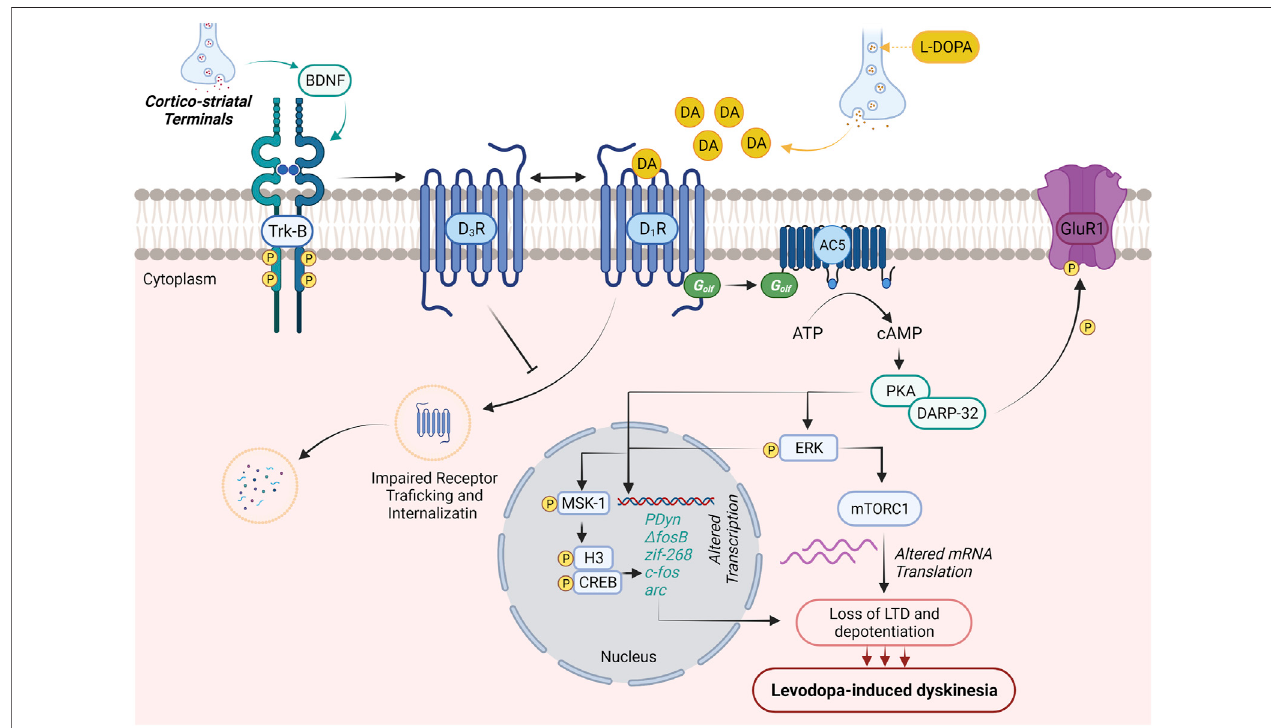
FIGURE 1 | Molecular neurobiology of levodopa-induced dyskinesia. DA production generally regulates voluntary movements. In PD patients, initial dopaminergic neurodegeneration in substantia nigra pars compacta is asymptomatic. Loss of striatal – nigral neuronal sensitizes the D1 receptor on the medium spiny neurons of the direct pathway. This results in initial motor symptoms of PD (dyskinesia). The treatment with L-DOPA improves the initial motor symptoms and promotes BDNF release from corticostriatal neurons. The expressed BDNF potentiates the expression of D3Rs through the activation of Tr κ -B receptors in nigrostriatal medium spiny neurons. Enhanced expression of D3Rs suppresses internalization and abnormal traf fi cking of membrane-bound D1Rs, thus intensifying D1R sensitization and associated dyskinesia. Activation of D1R by DA (released through L-DOPA) results in the activation of D1R/G α olf/adenylyl cyclase 5 (AC5) machinery in nigrostriatal medium spiny neurons and causes cAMP-mediated hyperexpression of protein kinase A (PKA) and DARPP-32. The abnormal PKA/DARPP-32 expression results in hyper-phosphorylation of GluR1 and promotes the excitability of medium spiny neurons contributing to the loss of long-term depression and depotentiation and developmentofLID.Ontheotherhand,activationofD1RresultsintheRas/Raf/MEK/ERKsignalingpathway,whichfurtherpotentiatesRas/Rafmachineryandregulates various transcription and translation processes regulating LID. PKA/DARPP-32 and/or ERK/Elk/MSK1 signaling migrates to the nucleus, leads to phosphorylation of CREB/histone H3, and augments the expression of immediate early genes (prodynorphin and Δ FosB), which are reported to contribute to the development of LID. Activated ERK further elevates mTORC1 expression-mediated mRNA translation and worsens